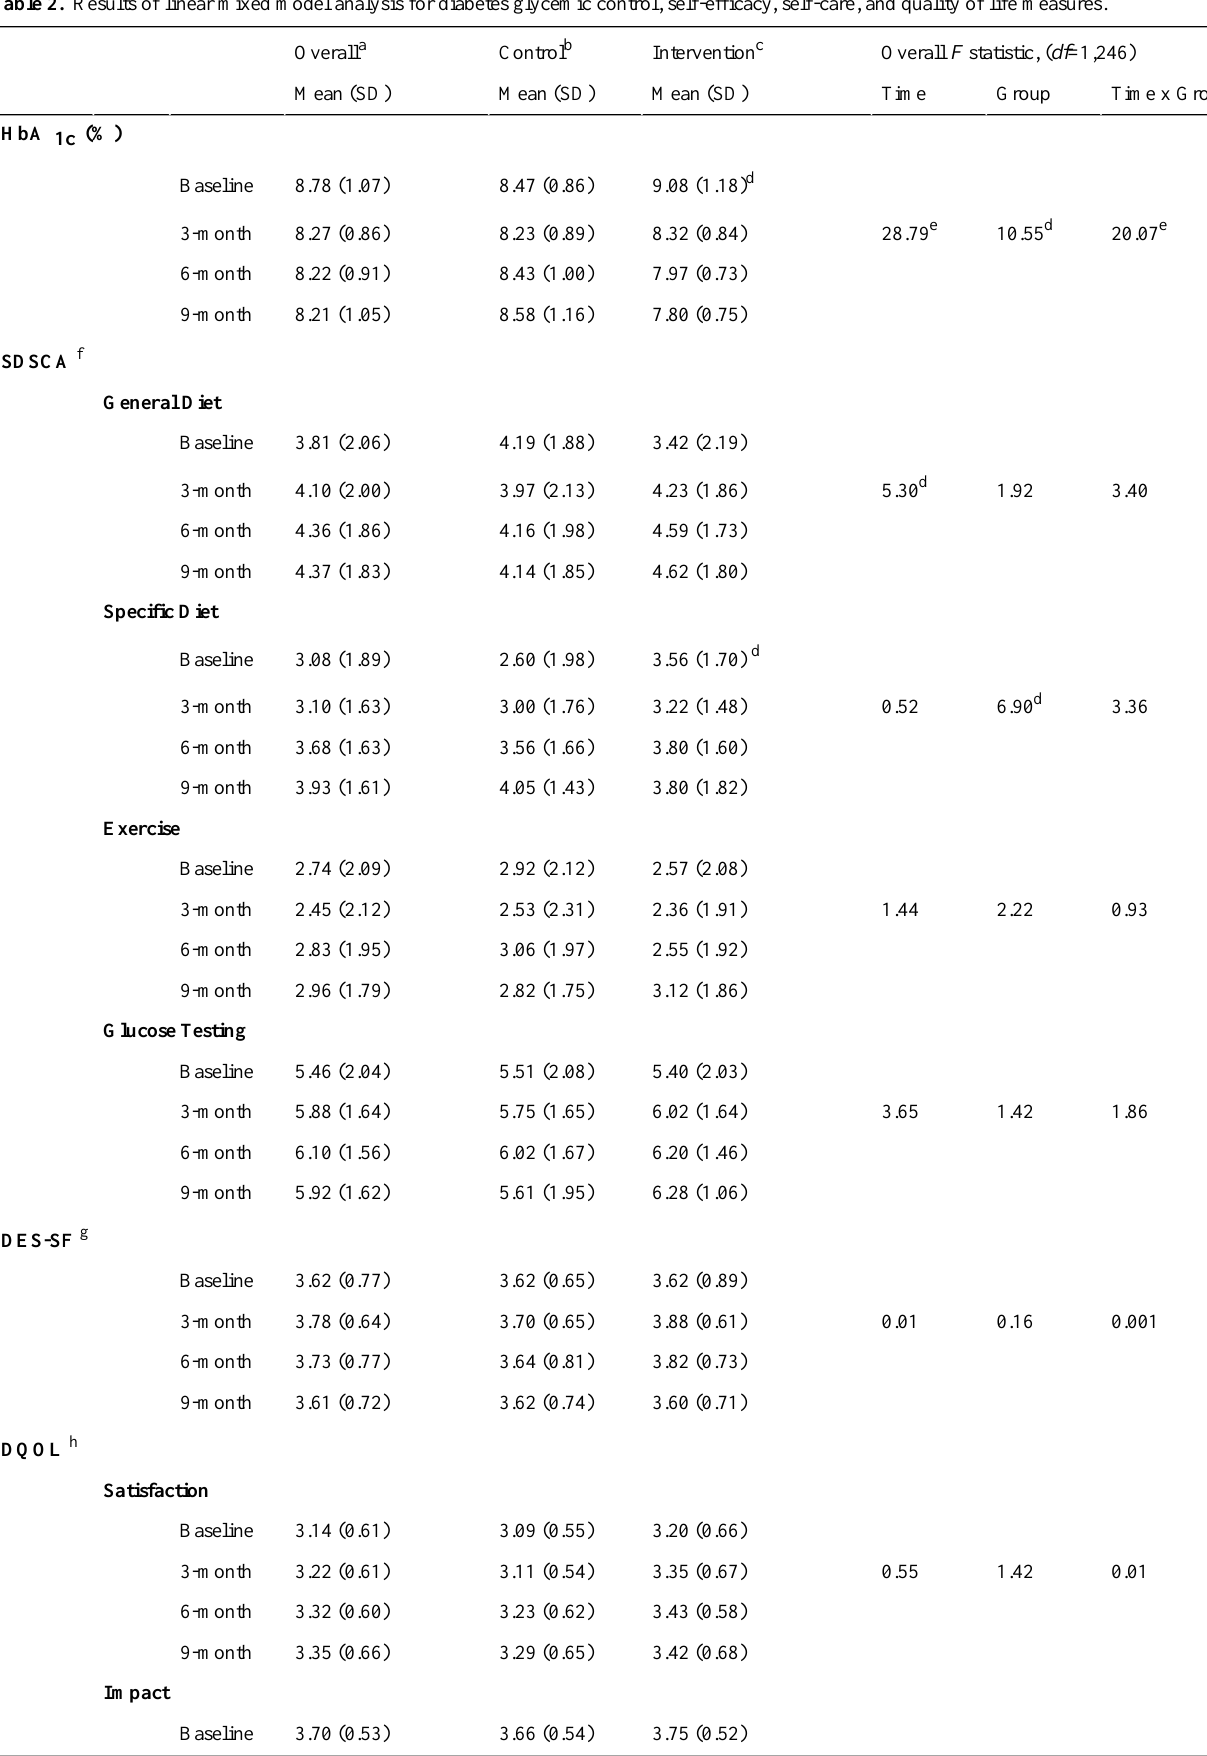
Table 2. Results of linear mixed model analysis for diabetes glycemic control, self-efficacy, self-care, and quality of life measures.